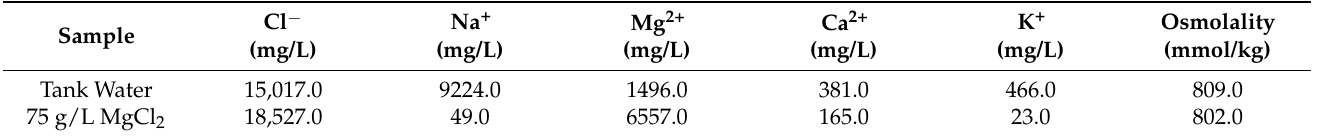
Table 2. Ion concentrations and osmolality for artificial seawater from sea star housing (tank water) and magnesium chloride solution (75 g/L MgCl 2 ).